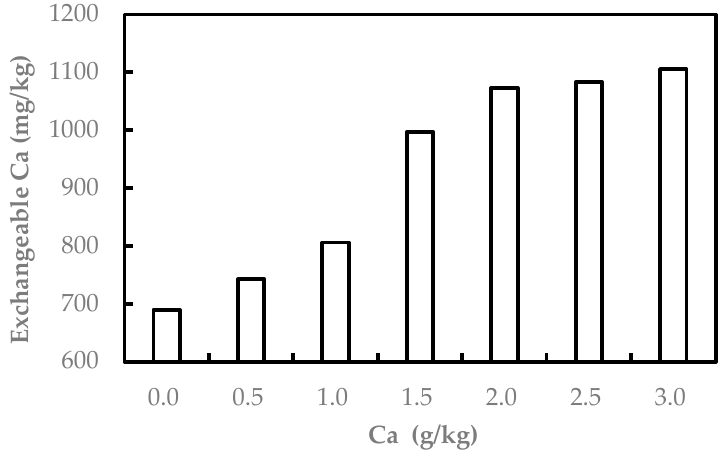
Figure 2. The exchangeable concentration of Ca in Ca-spiked pot soils. The total Tl concentration in the roots, stems, and leaves of green cabbage in the pot experiments is summarized in Table 4. For 12 mg/kg Tl(I) and Ca-spiked treated pot trials, the total Tl concentration increased by a maximum of 31.7%, 26.2%, 104%, and 88.7% in the roots, stems, leaves, and whole plants of green cabbage for the Ca-treated pots, respectively, relative to the non-Ca-treated control. For 8 mg/kg Tl(III) and Ca-spiked treated pot trials, the total Tl concentration increased by a maximum of 24.1%, 7.33%, 60.5%, and 57.4% in the roots, stems, leaves, and whole plants of green cabbage for the Ca-treated pots, respectively, relative to the non-treated control. It is interesting to observe that the total Tl concentration was significantly higher in the roots of green cabbage from the non-Ca-treated control than in the 1.0 g/kg Ca treatment. Similar results were also observed in the stems of green cabbage in 1.0 g/kg and 1.5 g/kg Ca-treated pots. Table 4. Concentration of Tl in the roots, stems, young leaves, old leaves, and whole plants of a single plant with 12 mg/kg Tl(I) or 8 mg/kg Tl(III) and various Ca-spike treatments (mean ± sd, n = 3, mg/kg).